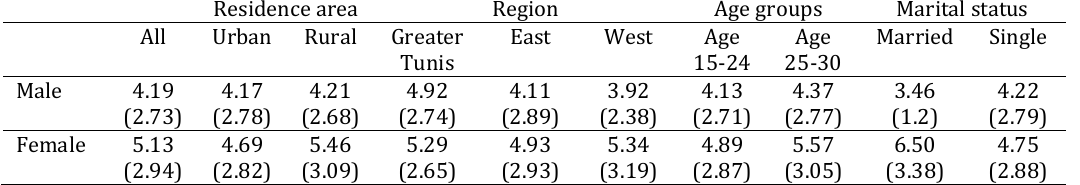
Table 3: Average unemployment duration by gender, residence, geographical area, age and marital status (years)